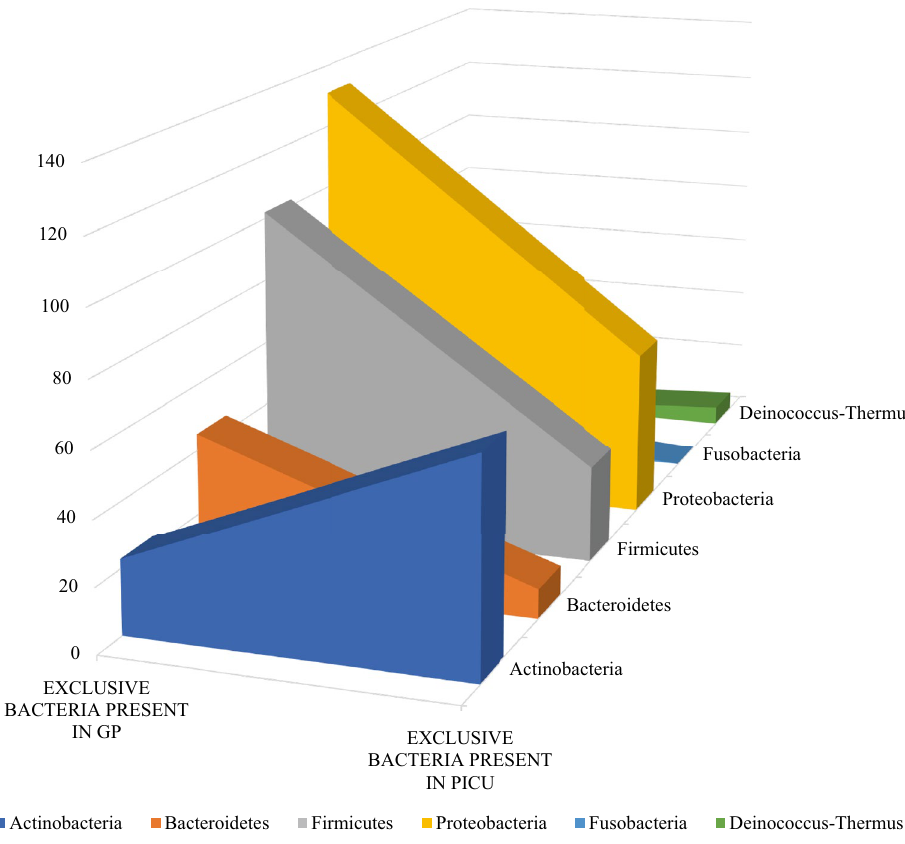
Figure 3. Phylum distribution of exclusive bacteria found present on General Paediatric Department or Paediatric Intensive Care Unit derived mobile